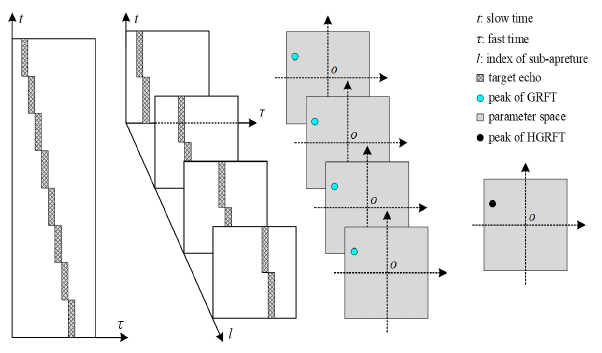
Figure 7. The algorithm flowchart of